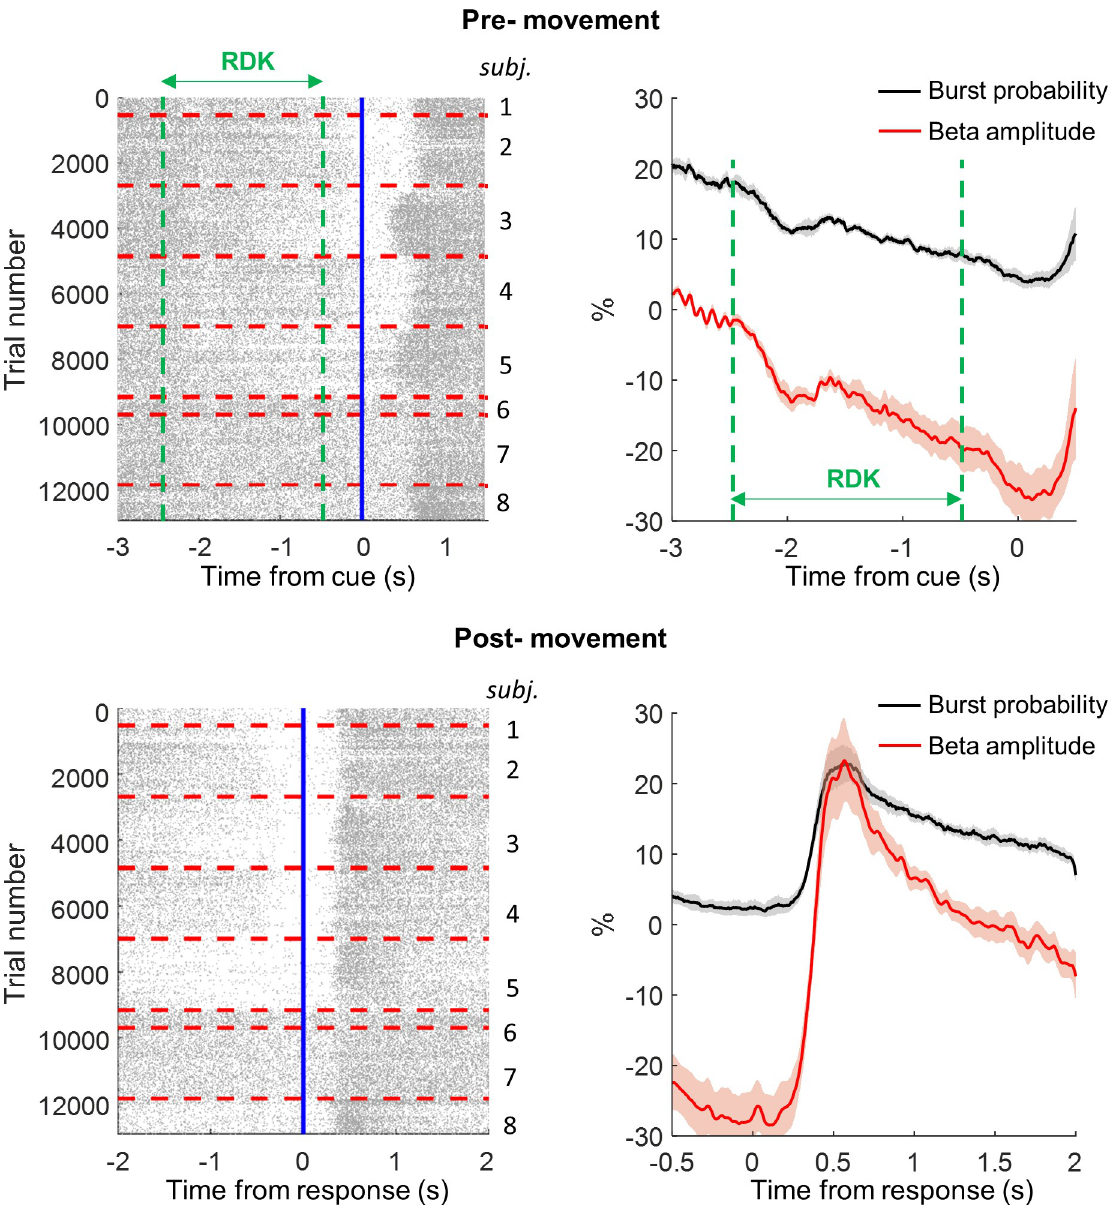
Fig 5. Trial-averaged beta amplitude of ERD and ERS is mirrored by burst probability across trials. Raster plots showing the timing of each individual burst (single dash = peak of burst) for all trials of all 8 subjects ( > 12,000 trials; individual subjects divided by dashed red lines). Top left panel: raster plot of beta bursts, locked to the imperative stimulus. Lower left panel: raster plot of beta bursts, locked to movement response. There is a consistent relationship of burst timing to movement onset, with a gradual reduction in burst probability in the time building up to movement, followed by a significant increase (weakly temporally locked) in burst probability after movement. Top right panel: normalised (percent versus pre-movement preparation [500-millisecond] baseline) average ERD ± SEM (red) is shown in the pre-movement period, with burst probability (%) overlaid (black). Lower right panel: same analysis for the post-movement ERS period, using the same baseline. The classical event-related desynchronisation (‘ERD’) and event-related synchronisation (‘ERS’) are shown in the pre- and post-movement periods, respectively, and mirrored in shape by the across-trial burst probability. The underlying data can be found at https://osf.io/eu6nx/. ERD, event-related desynchronisation; ERS, event-related synchronisation; RDK, random dot